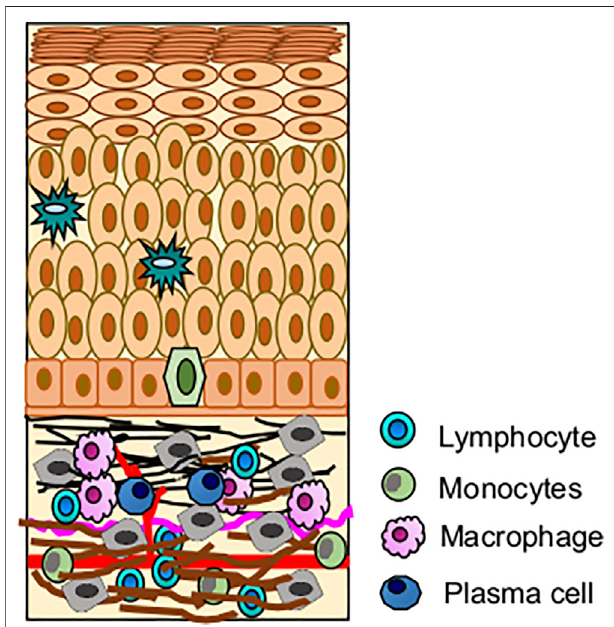
FIGURE6| HyperkeratoticepithelialcellsinOSMF.Immuneactivationin OSMF show the presence of different types of immune in fi ltrates in submucous layer. Increase in fi broblast cells leads to high production of collagen fi bres (brown bar) leading to fi brosis of oral mucosa.